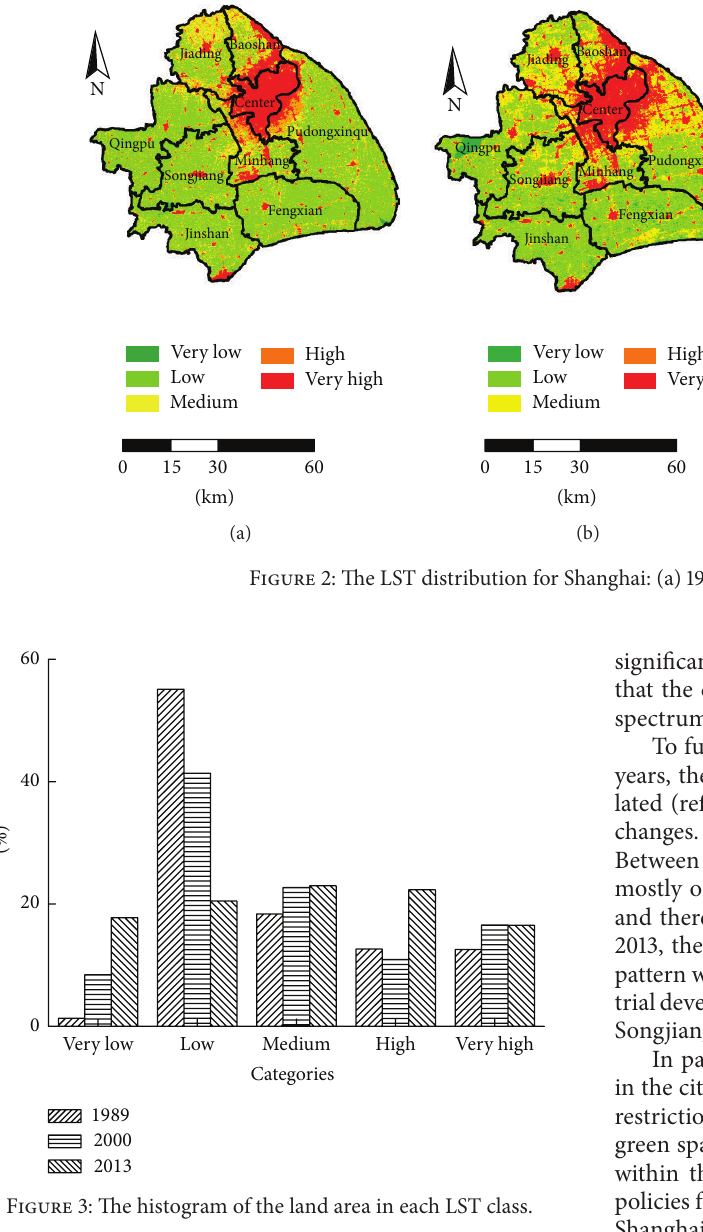
LST differentials have become more obvious, showing a more diverse distribution towards the two extremes on the LST spectrum: for example, the Dianshan Lake in the west of Qingpu district was primarily categorized as “low” in 1989, because the LST was not significantly lower than city center (within 1 standard deviation from average LST according to Table 1). However for 2000 and 2013, it had shifted to “very low” because the LST difference had increased and become larger than 1 standard deviation from average LST. Similar patterns were also observed in rural areas in Jinshan district and the east of Pudong district along